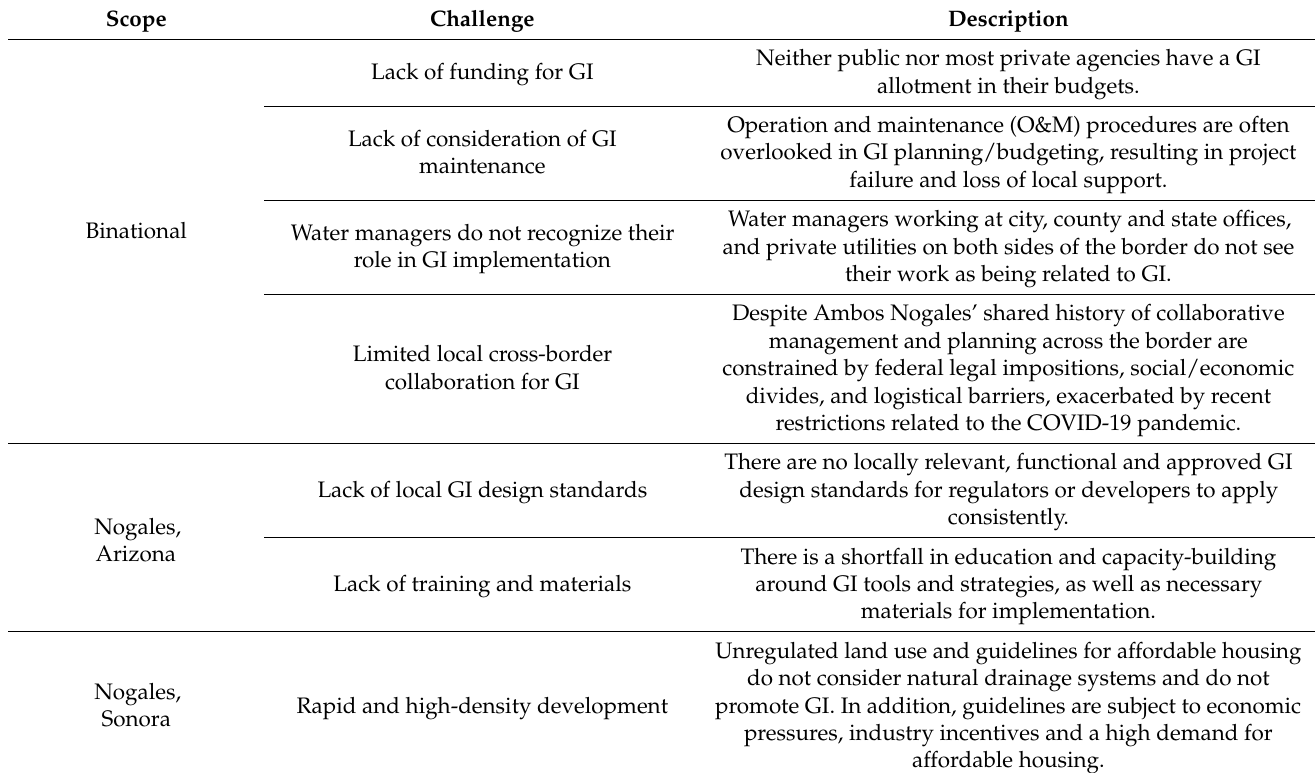
Table 5. Challenges for GI implementation (not related to policy)